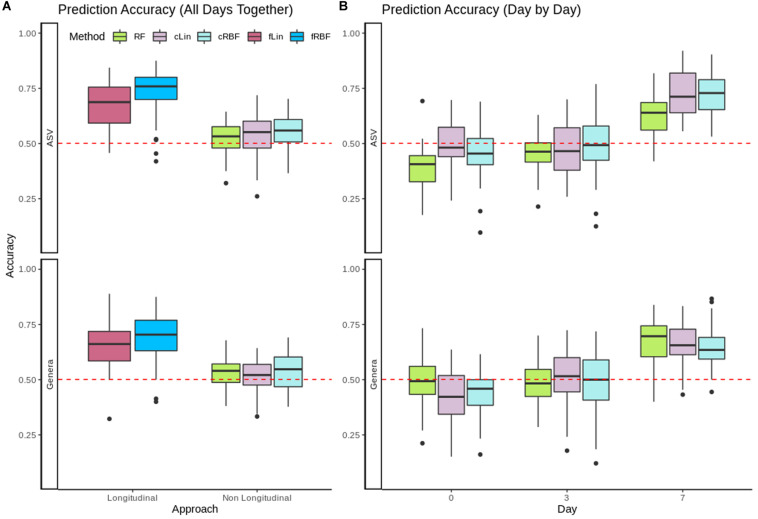
(A) Accuracy for RF, non-longitudinal kernels (cRBF, cLin) and Longitudinal kernels (fLin, fRBF) in the prediction of neonatal diarrhea from all available days. (B) Accuracy for RF and non-longitudinal cLin and cRBF kernels from metagenomic data of days 0, 3, and 7 post-birth separately. In both panels, the red dashed line marks the accuracy of the random model.